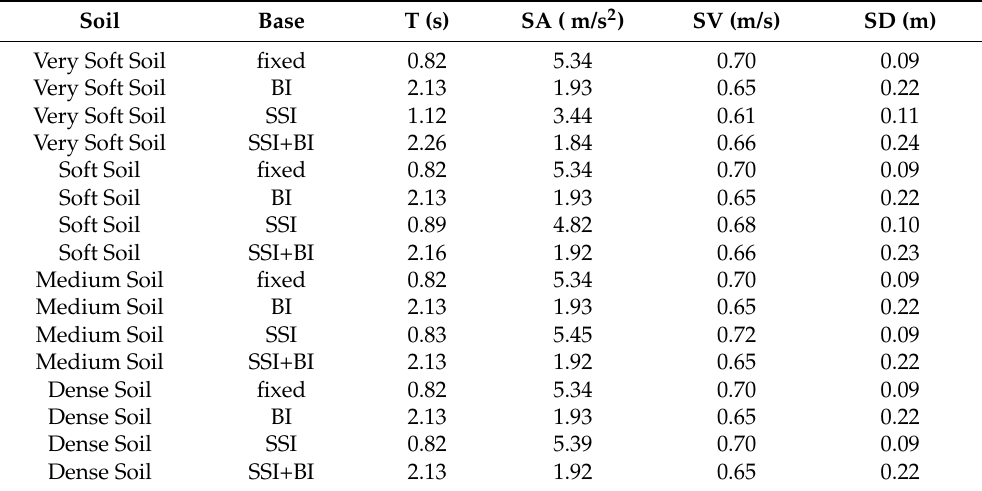
Table 9. Spectral analysis results of the five-story building (Imperial Valley,